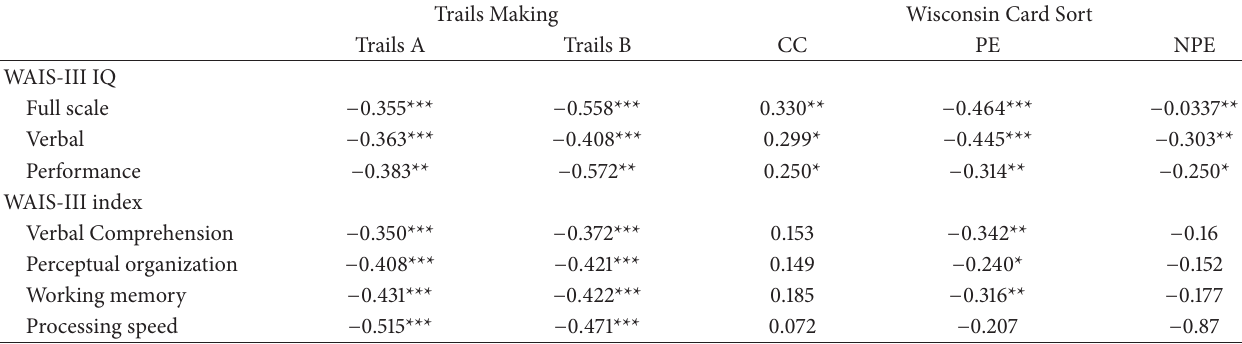
Table 2: Correlations of WAIS-III summary measures with Trail Making and Wisconsin Card Sort.